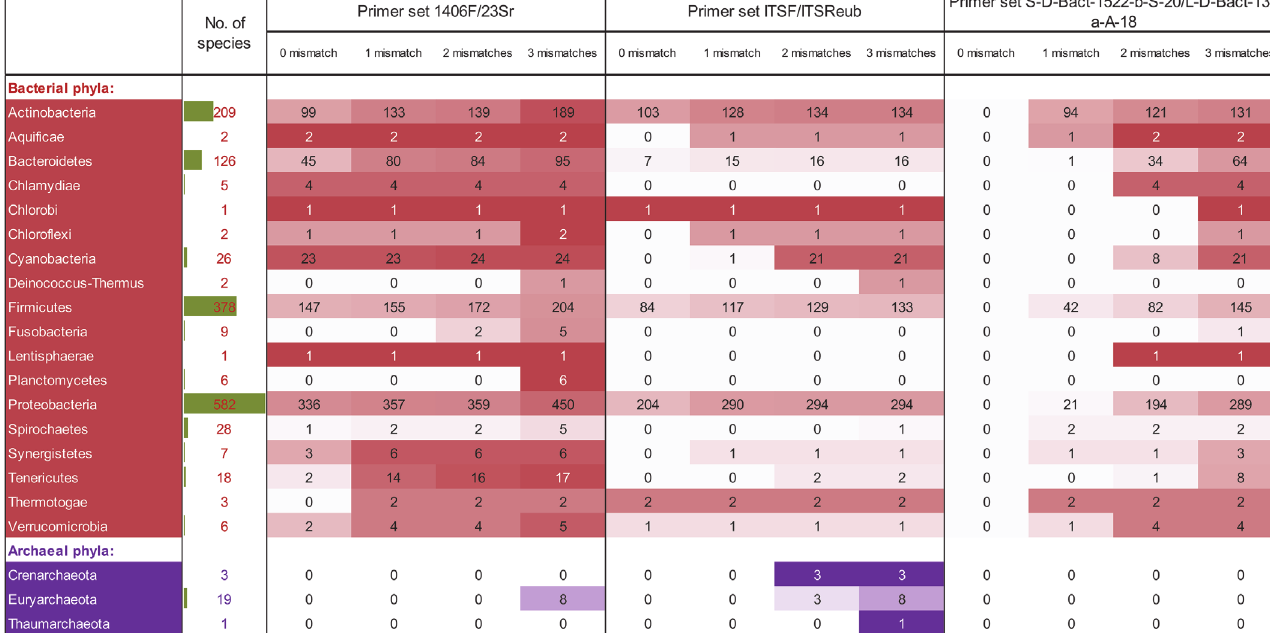
Fig 1. Number of potentially amplified species for different prokaryotic phyla in the wgs-embl-pro database revealed by ecoPCR by increasing mismatches allowed on both forward and reverse primers. The overlaid heatmap (white = 0, darkest = maximum number of sequences) illustrates rising anticipated amplification success with increasing mismatches and was applied per row (i.e. heatmap is proportional to the sequence number available per phylum). The in-cell bar illustrates the relative contribution of the phyla in the used database.